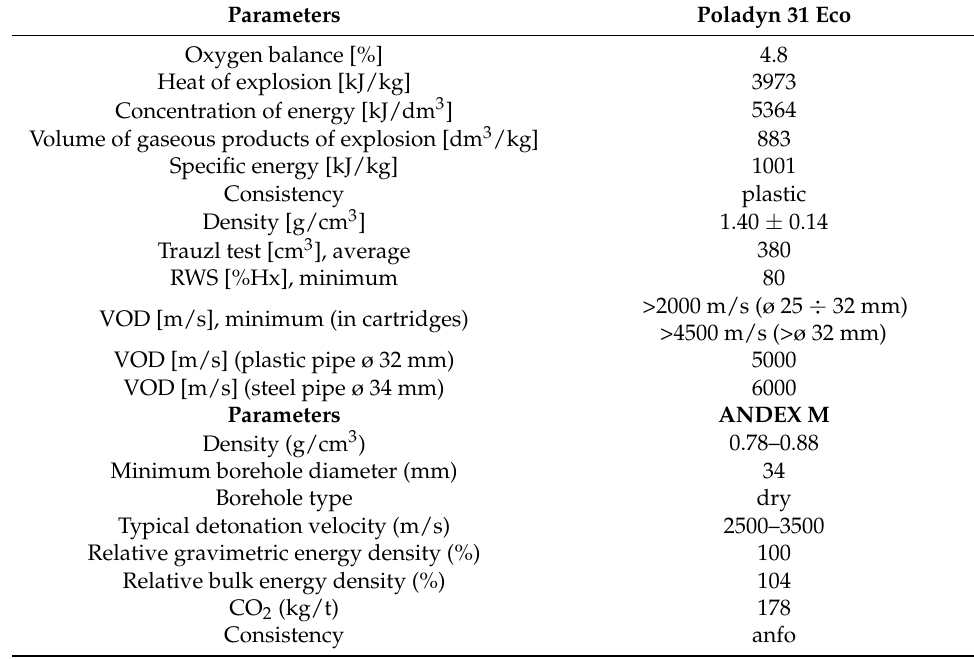
Table 1. Parameters of the Poladyn 31 Eco and Andex M explosive [53].